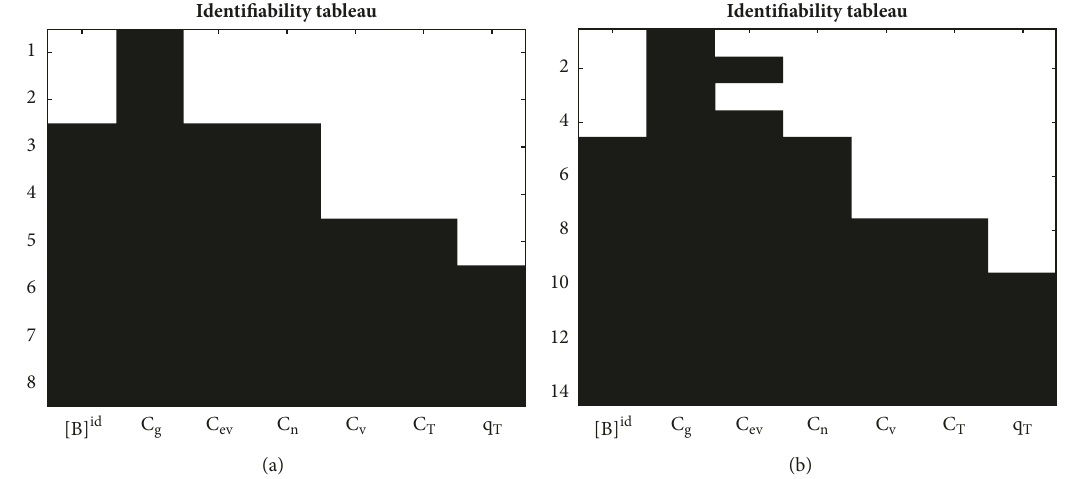
Figure 9: Complete identifiability tableaus of the reduced model in the case when the output is 𝑉 𝑡𝑜𝑡 (a) and in the case when the output is [𝑉 , 𝐵] 𝑡𝑜𝑡